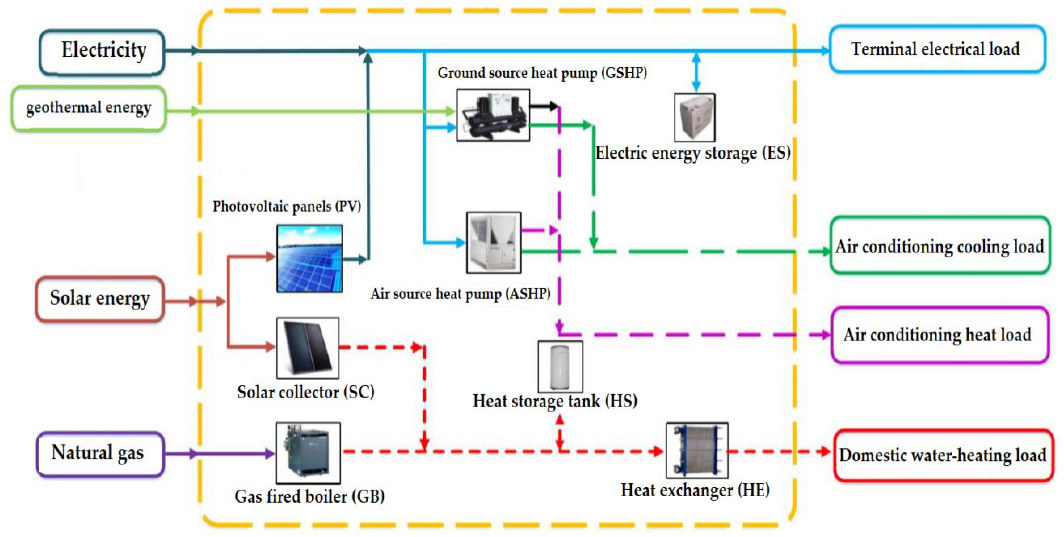
Figure 1. Energy supply structure of the final MCS.